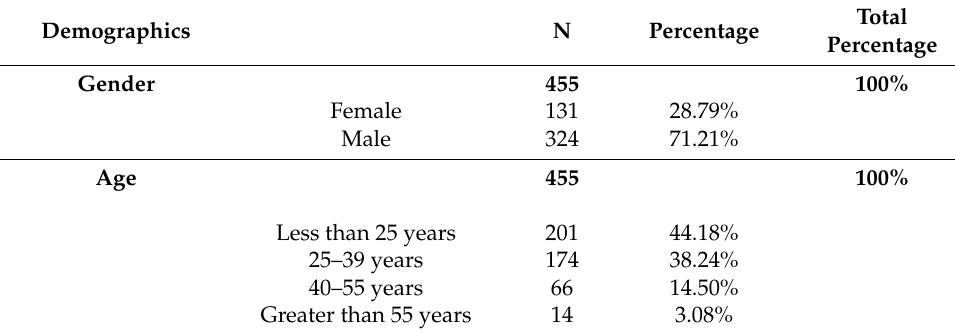
Table 1. Descriptive Analysis of the demographics of the